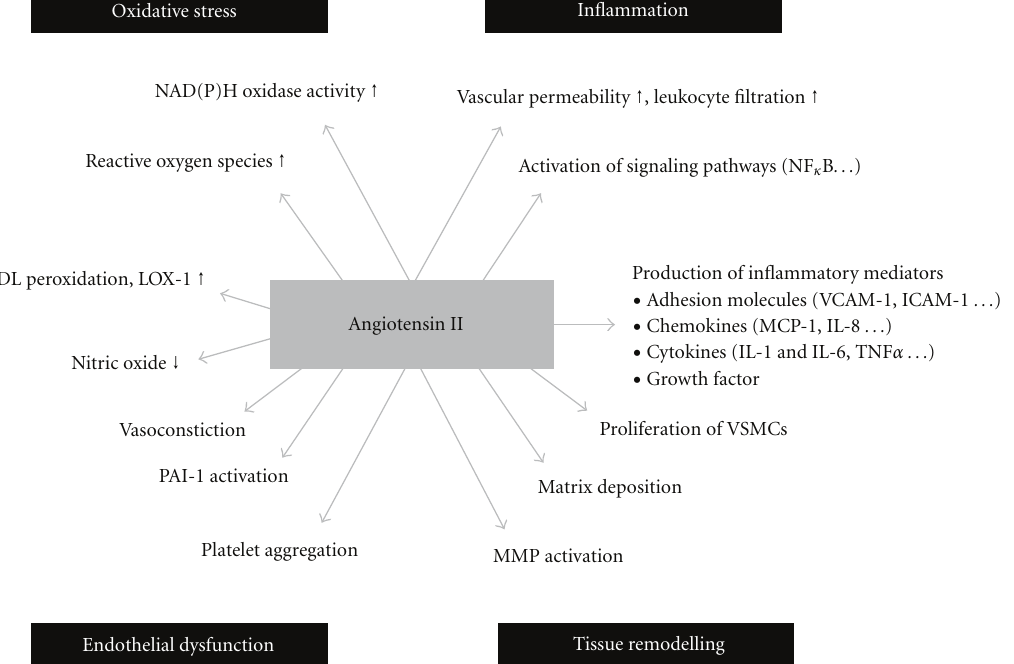
Figure 2: Important e ff ects of angiotensin II on mechanisms associated with atherosclerosis. Reprinted with permission from Schmieder et al.